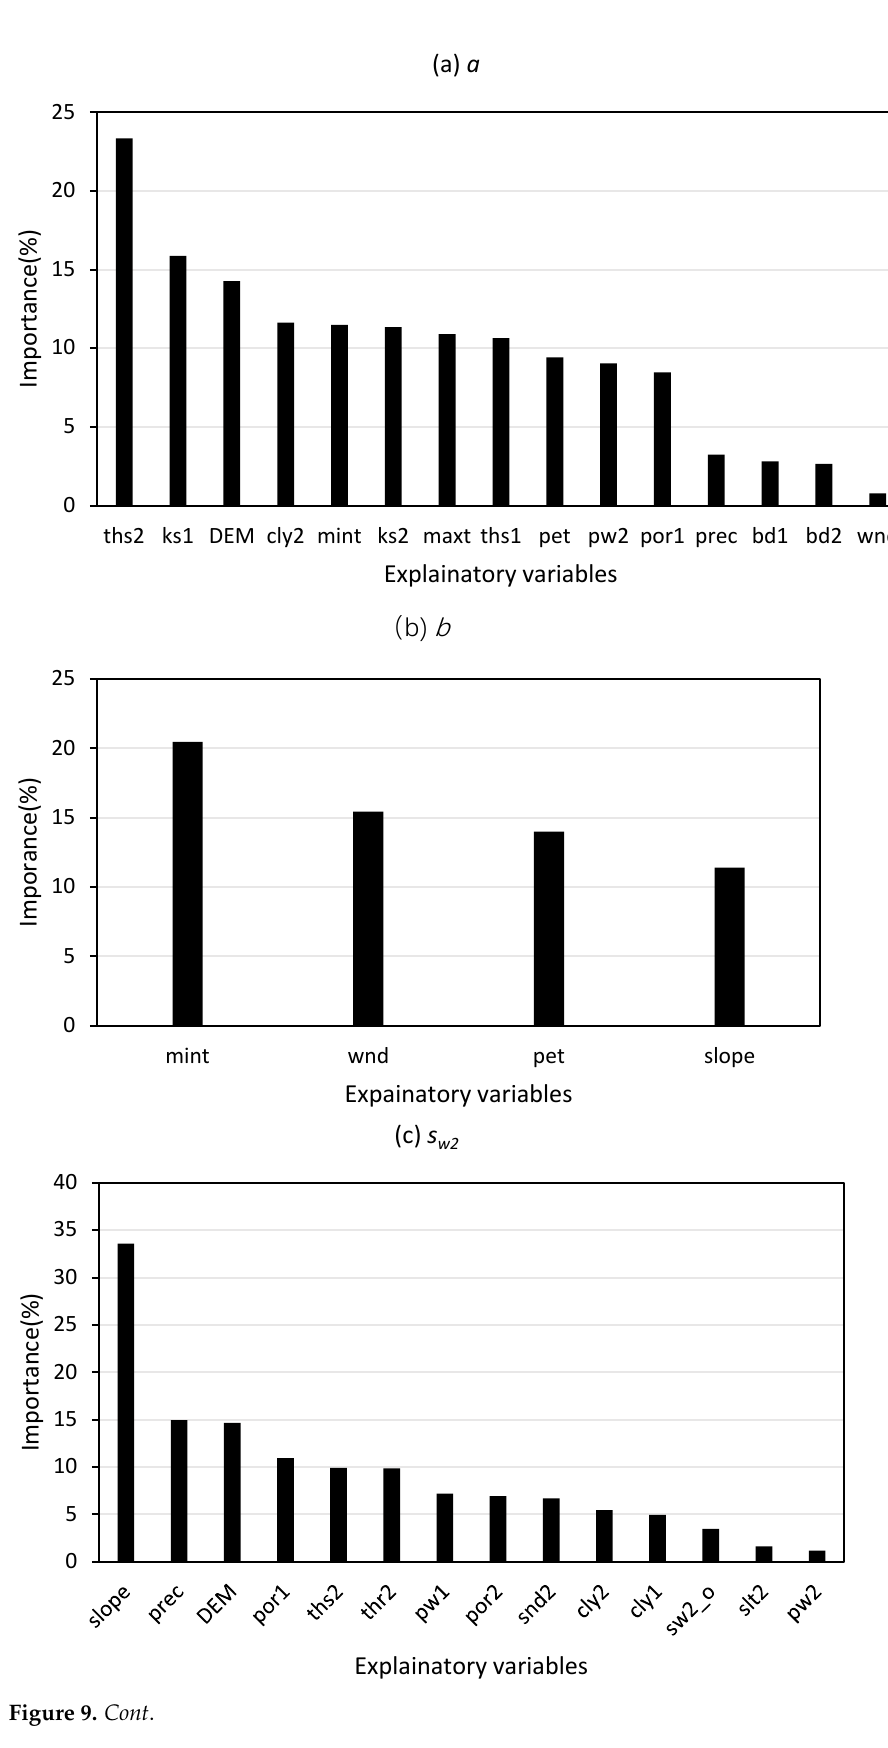
Figure 9. Relative importance (%) of soil, climatic and vegetation characteristics to ( a ) a , ( b ) b , ( c ) s w2 and ( d ) s c1 from the random forest model, sorted from largest to smallest. Suffix 1 represents the near-surface soil layer (0–5 cm), and suffix 2 represents the root-zone soil layer (5–100 cm). 5. Conclusions This study explored the feasibility of regionalizing the SMAR model with the RF re- gression method and discussed the importance of explanatory variables. In this study, a SMAR model at the point scale was established with parameters calibrated by a GA and validated by in situ root-zone soil moisture. Then, the regional SMAR parameters were predicted by a RF model with soil, climatic and vegetation characteristics as explanatory variables, and the importance of these explanatory variables was discussed. Finally, the performance of the regional SMAR model for estimating RZSM was validated. The point-scale SMAR model obtained reliable RZSM and captured its fluctuations at most sites, with RMSE less than 0.06 cm 3 ·cm − 3 and correlation R greater than 0.5. Spa- tially, the SMAR model obtained more accurate RZSM in the central and western parts of the region. Temporally, the SMAR model tended to underestimate the RZSM during the growing season and overestimate the RZSM during the nongrowing season, and we sup- pose that it is related to the constant water loss efficiency for the whole year.